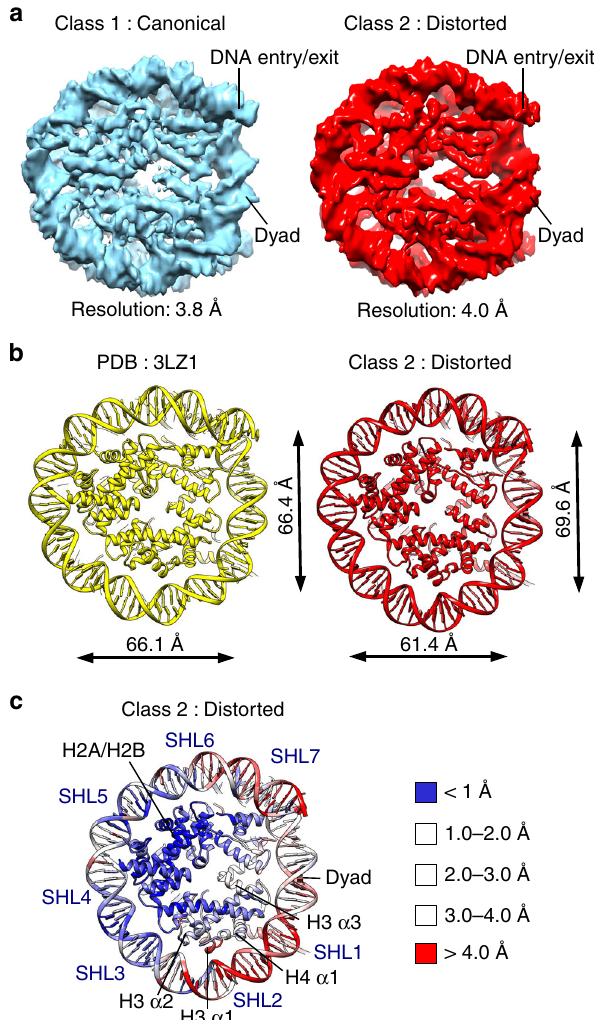
Fig. 1 Structural plasticity of the nucleosome core particle (NCP). a Cryo- EM maps of the NCP in two distinct conformations. Class 1 (left, blue) resembles canonical nucleosome, whereas Class 2 (right, red) is in distorted conformation. Class 1 is resolved to 3.85 Å and Class 2 to 4.05 Å (0.143 cutoff in FSC curve). Class 1 contains 51 000 particles and Class 2 contains 58 000 particles. b Global changes in the nucleosome structure. Comparison of X-ray structure (PDB:3LZ1) and Class 2 (distorted nucleosome) models. The nucleosome core particle contracts along the symmetry axis by 8% (distance between nucleotides 2 and 38) and expands in the perpendicular direction by 5% (distance between nucleotides 17 and 58). c RMSD between the X-ray structure (PDB:3LZ1) and the Class 2 model, showing the extent of rearrangements in the NCP. The X-ray structure and the Class 2 model were superimposed and RMSD of C α was calculated and depicted. DNA at SHL 1 – 2 and SHL 6 – 7 shows the largest movements between these two structures (> 4 Å). H3 α 1, α 2, and